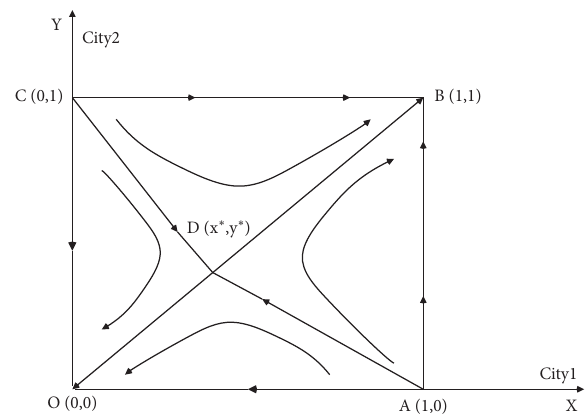
Figure 6: Phase diagram of the evolutionary game of cooperative air pollution control without